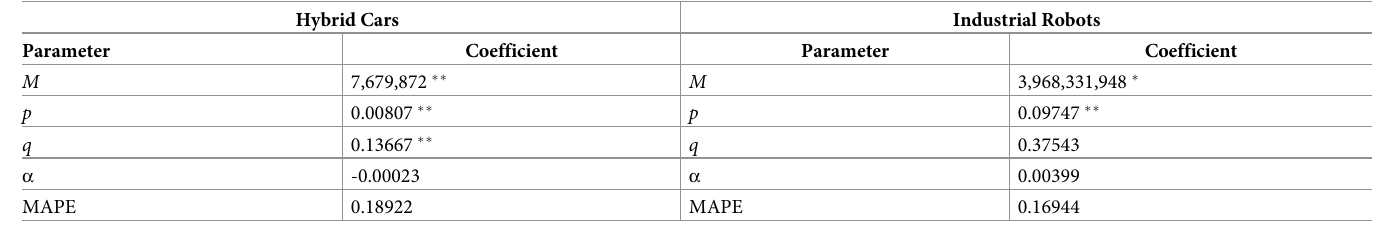
Table 4. Estimation results of the modified Bass model using patent